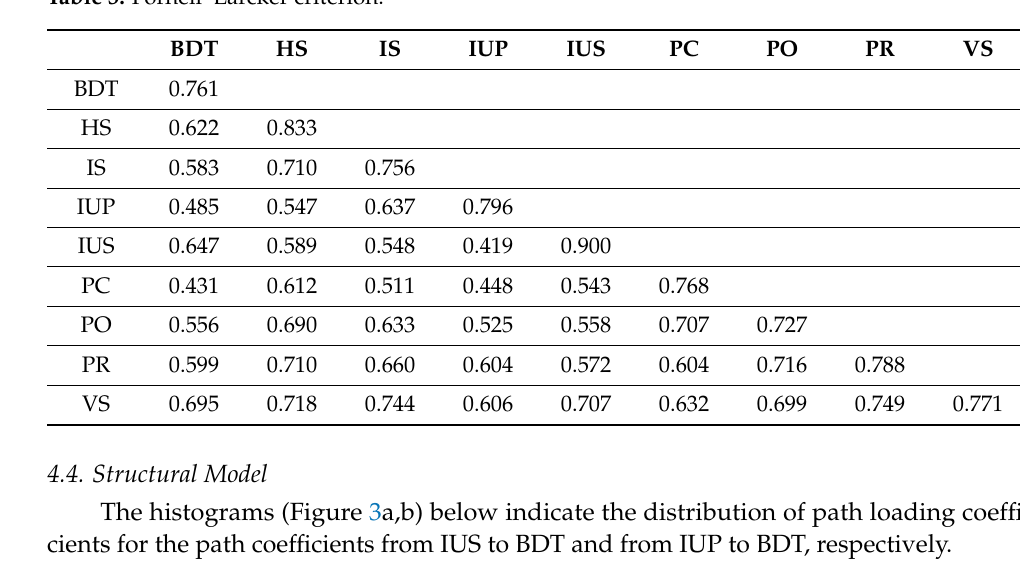
Table 3. Fornell–Larcker criterion.